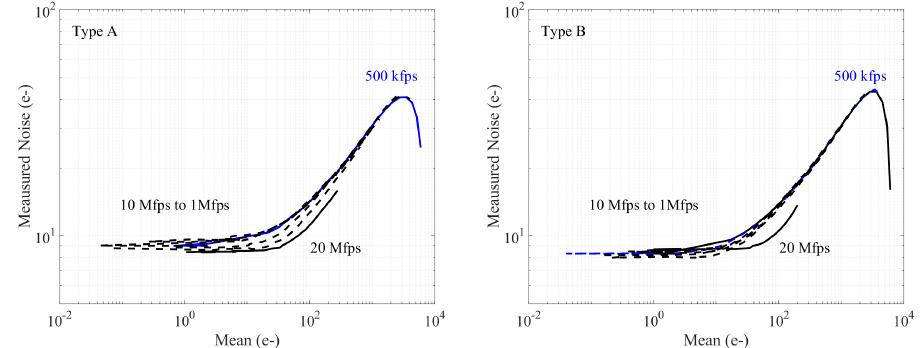
Figure 12. The PTCs for Type A and Type B measured at speeds from 500 kfps to 20 Mfps. Different curves present different operation frequencies. Due to the limited LED power, only the pixels at the 500 kfps case can reach the saturation region.